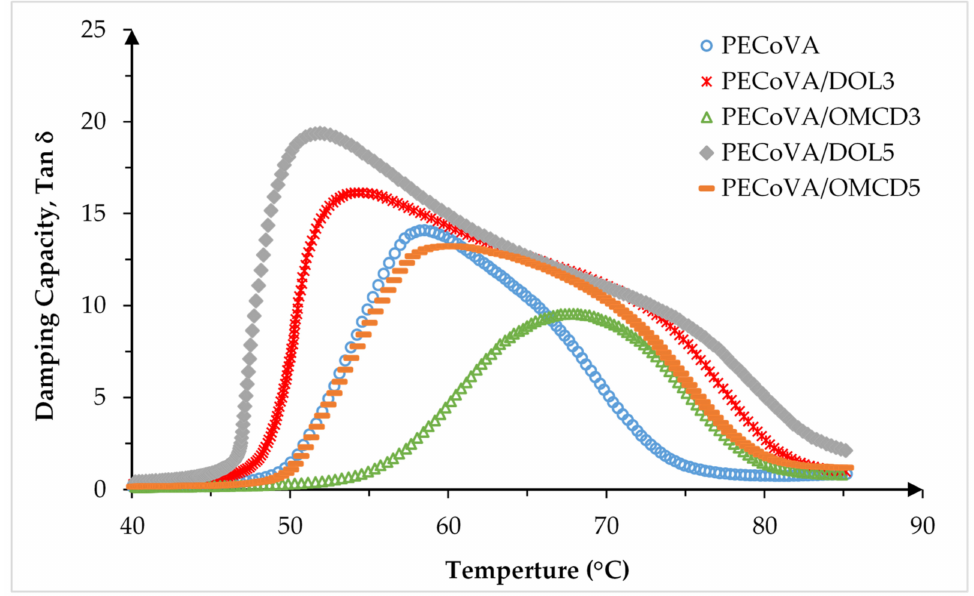
Figure 12. Effect of dolomite filler loading on the damping capacity (Tan δ ) of virgin PECoVA, PECoVA/DOL and PECoVA/OMCD